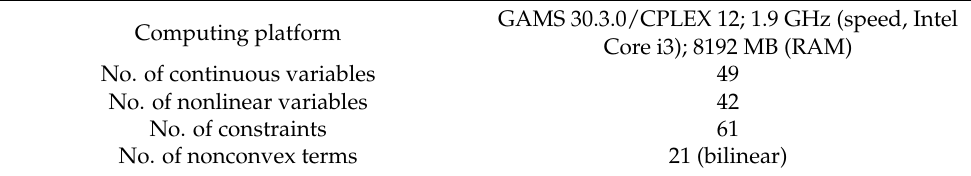
Table 2. Model size and computational statistics for refinery planning NLP